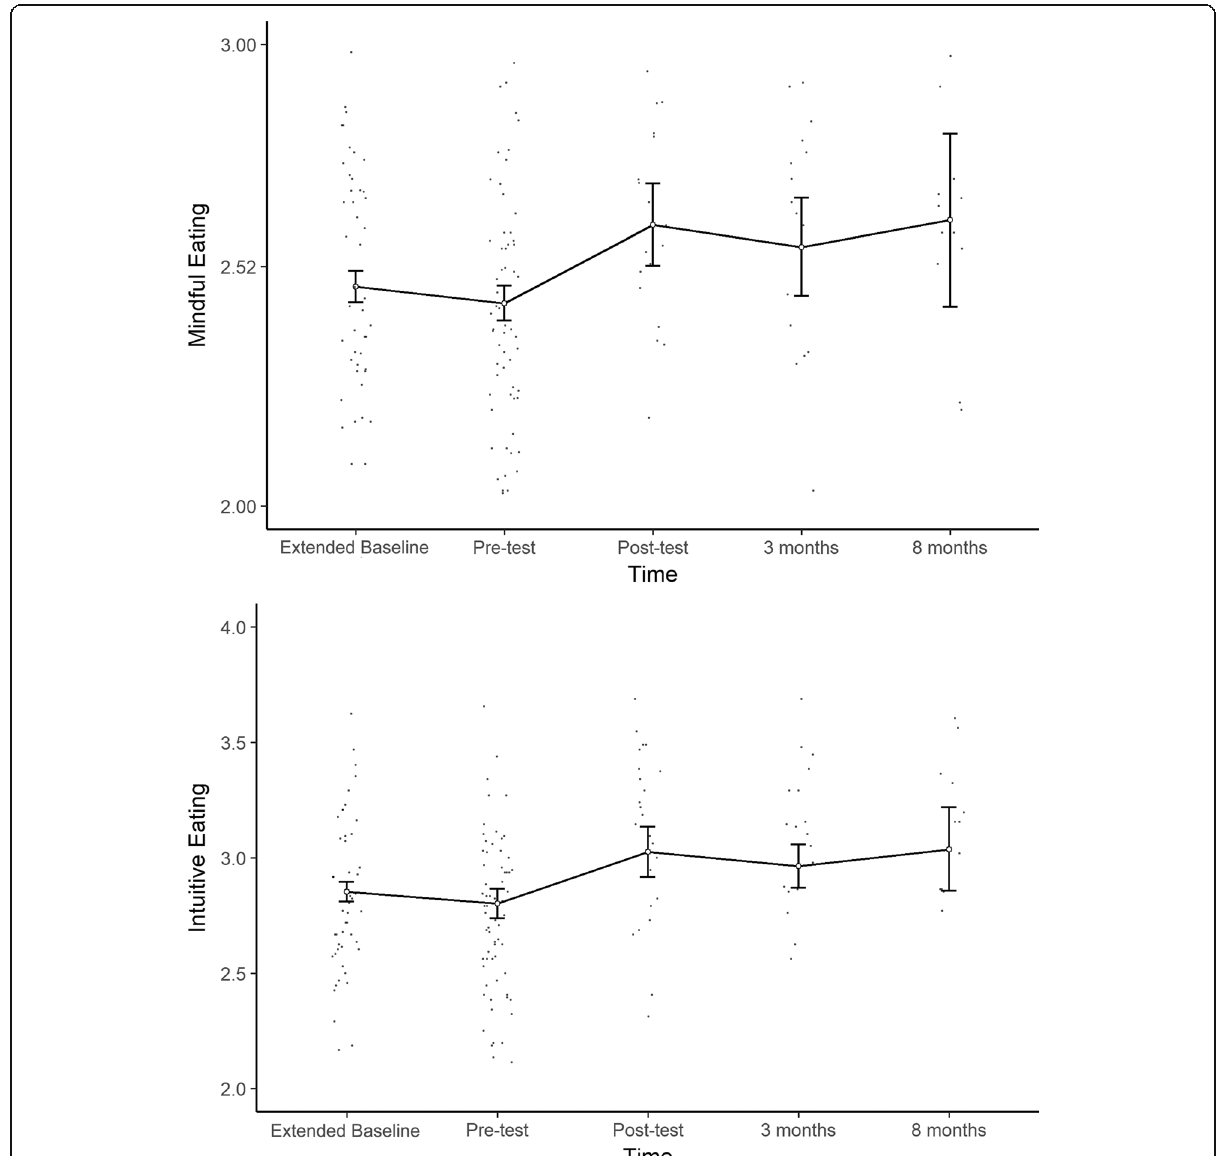
Fig. 3 Trajectories of problematic eating behaviors across time. Dots represent individual scores for each timepoint. White dots and error bars indicate means and 95% confidence intervals for each timepoint